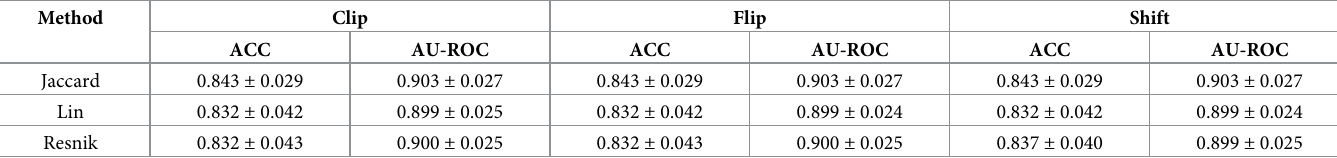
Table 3. Nested cross-validation (outer folds) model performance estimates. Model performance of semantic similarity measures over methods of approximating the nearest PSD matrix. The Jaccard index does not require matrix correction but is shown for comparison.